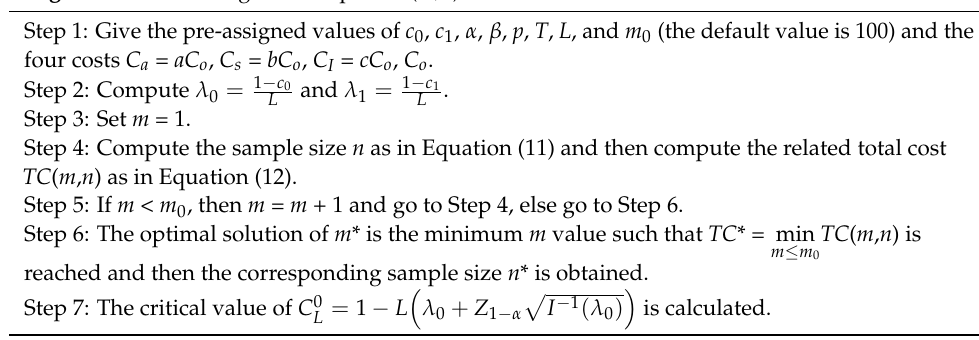
Algorithm 1 Searching for the optimal ( m , n